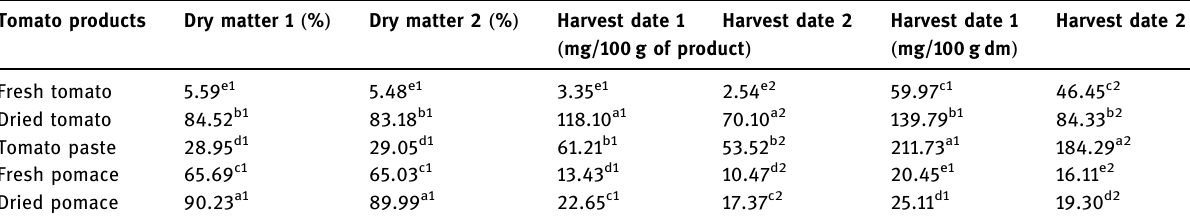
Table 1: Lycopene content in tomatoes and its products Tomato